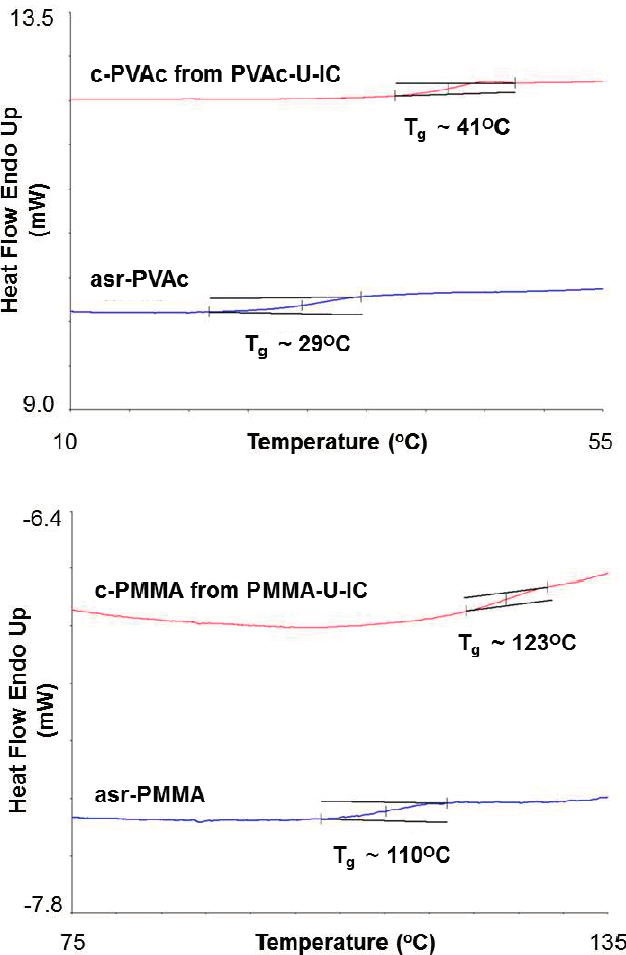
Table 1. Densities of asr- and c-PVAcs measured below and above their T